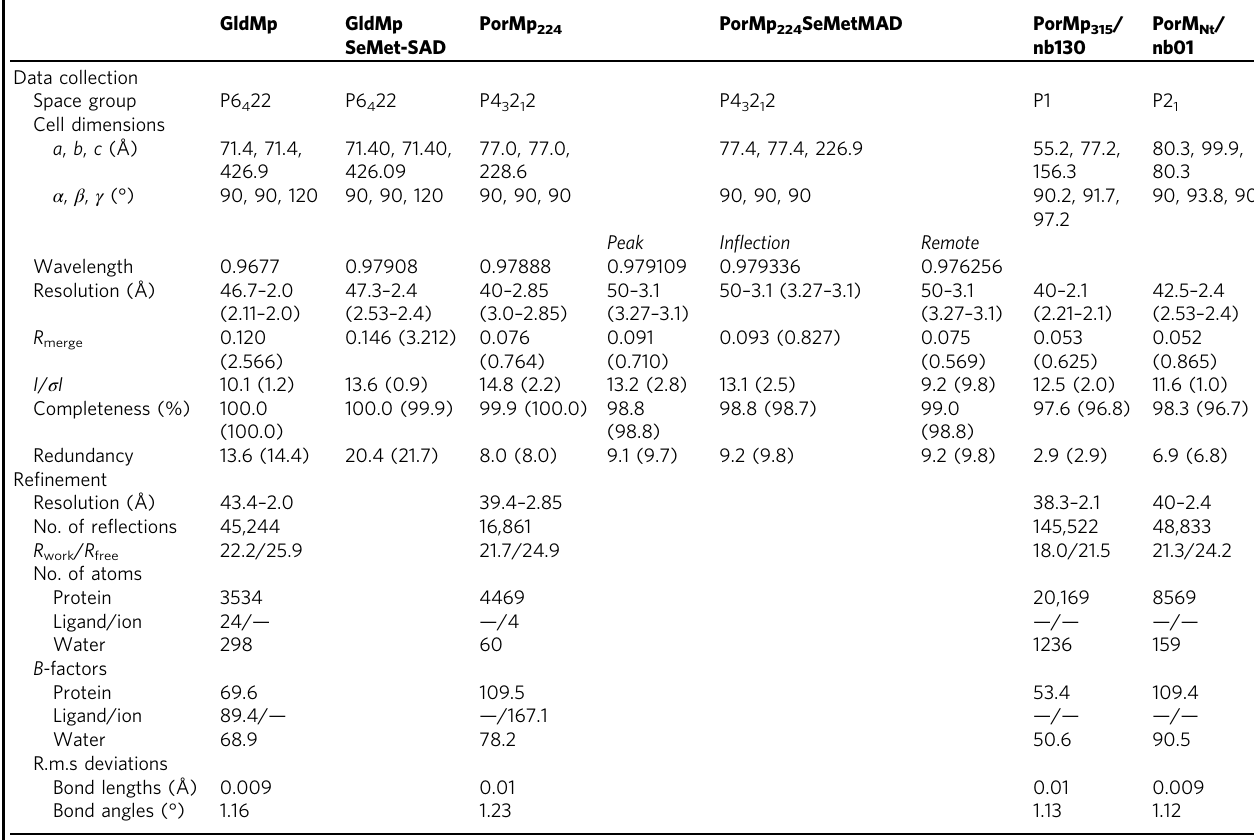
Table 1 Data collection phasing and re fi nement